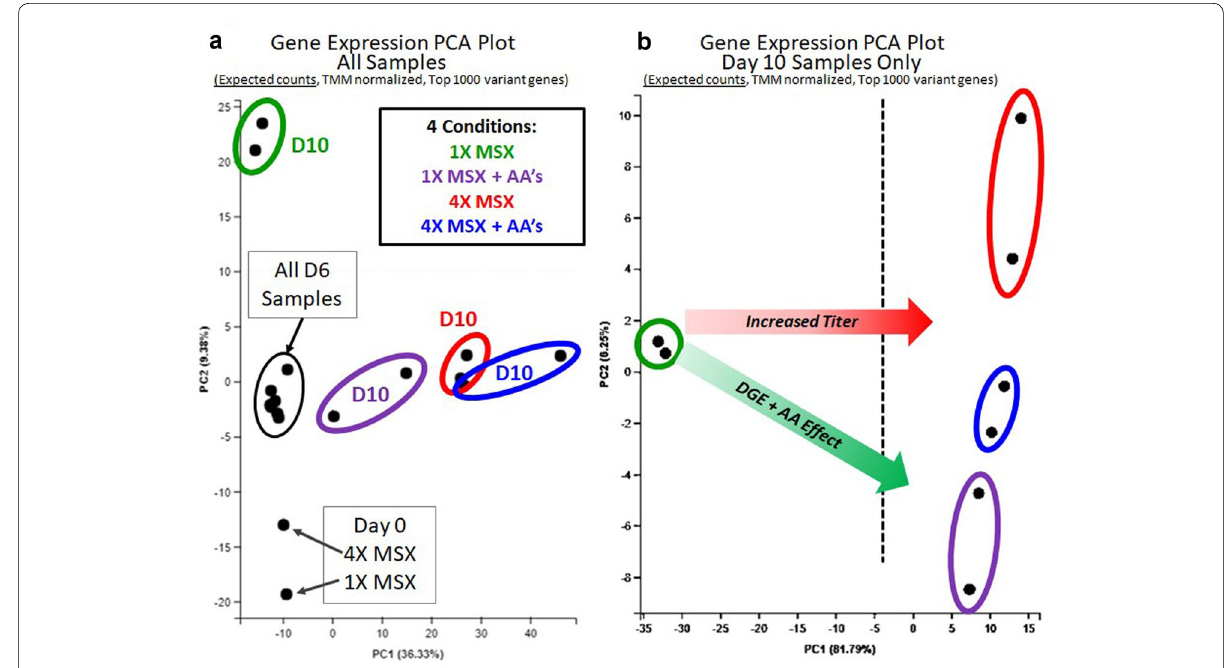
Fig. 4 PCA plots of a all bioreactor conditions at day 0, 6, and 10, and b day 10 samples only